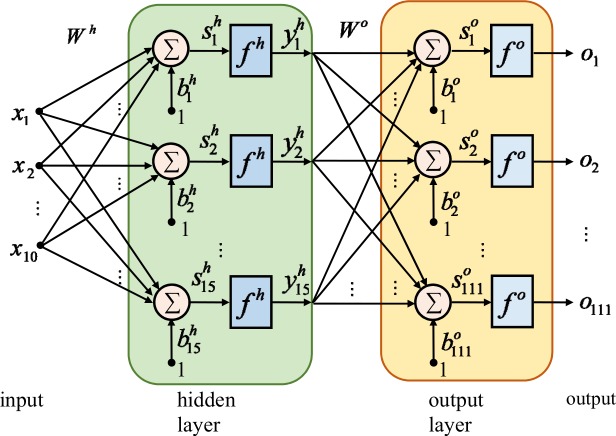
Architecture of the ANN of the metamodel for the 1st waveform family.